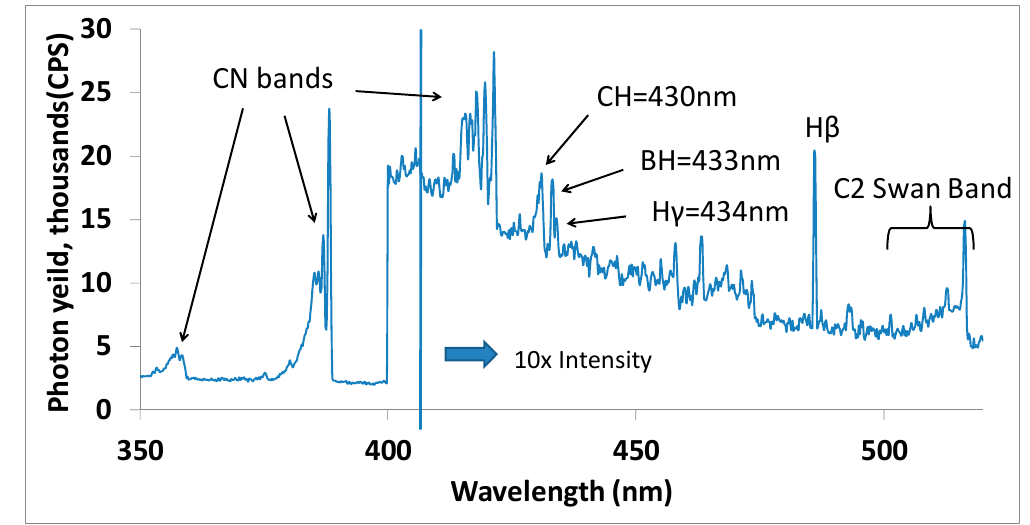
Figure 4. Optical emission spectrum from a H 2 /CH 4 /N 2 /B 2 H 6 plasma during a microwave plasma deposition experiment. The microwave power in 1.2 kW and the chamber pressure is 38 torr.